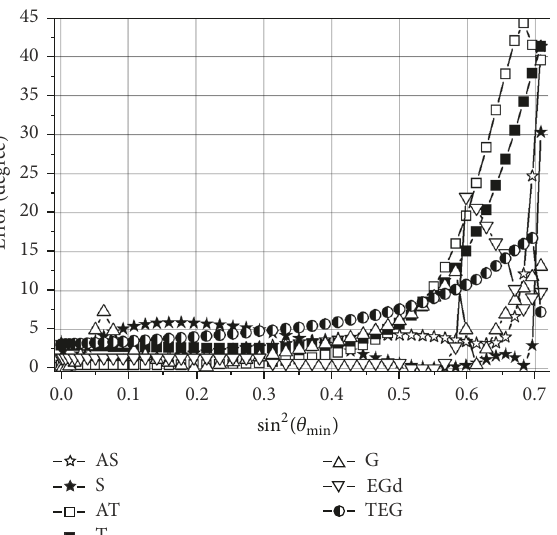
Figure 5: Techniques of low quality, variant 𝑉 𝑃3 = 4800 . The error for the fixed maximum offset.